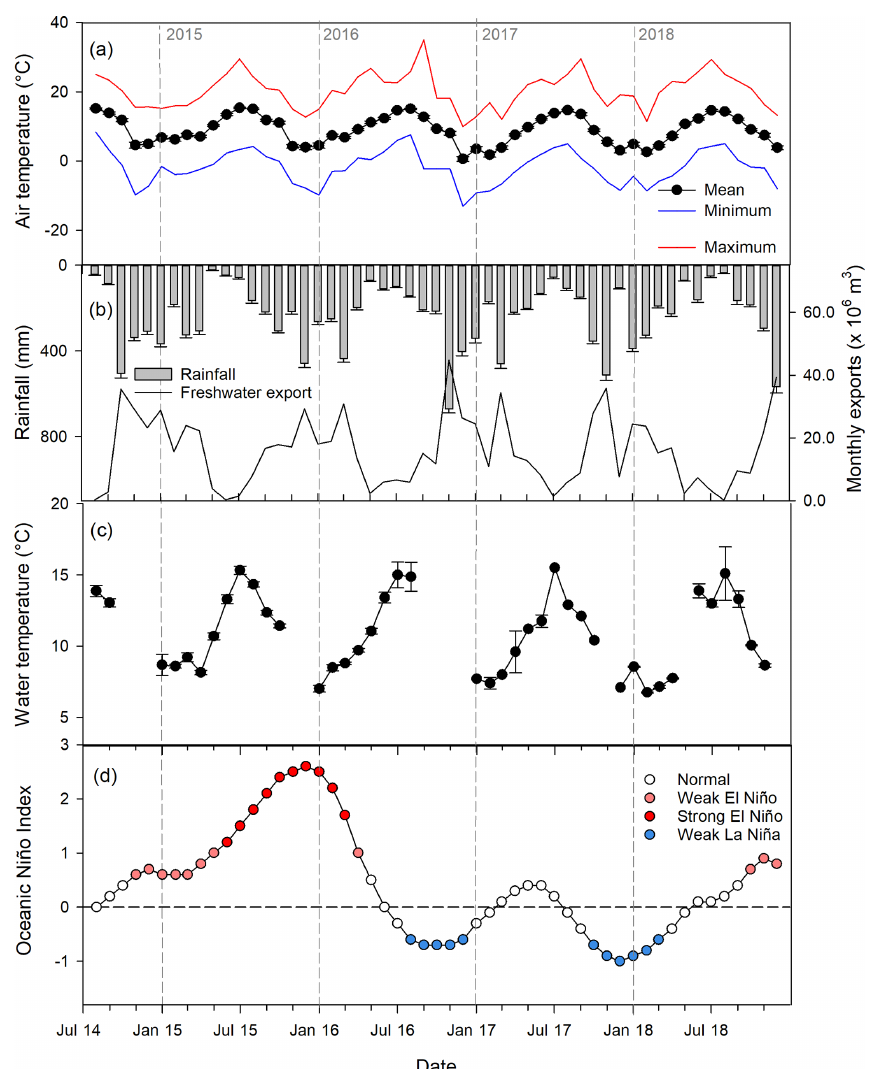
Figure 2. Climatology of the Calvert and Hecate islands over the study period (1 August 2014 to 31 December 2018): (a) monthly mean, minimum, and maximum air temperature across the seven watershed outlets; (b) mean monthly rainfall across the seven watershed outlets and total monthly discharge to the Kwakshua Channel system; (c) mean ± SE surface water temperature at the marine stations during sampling events, measured using an YSI; (d) Oceanic Niño Index, with El Niño and La Niña events highlighted based on thresholds greater than ± 0.5 (weak event) or greater than ± 1.0 (strong